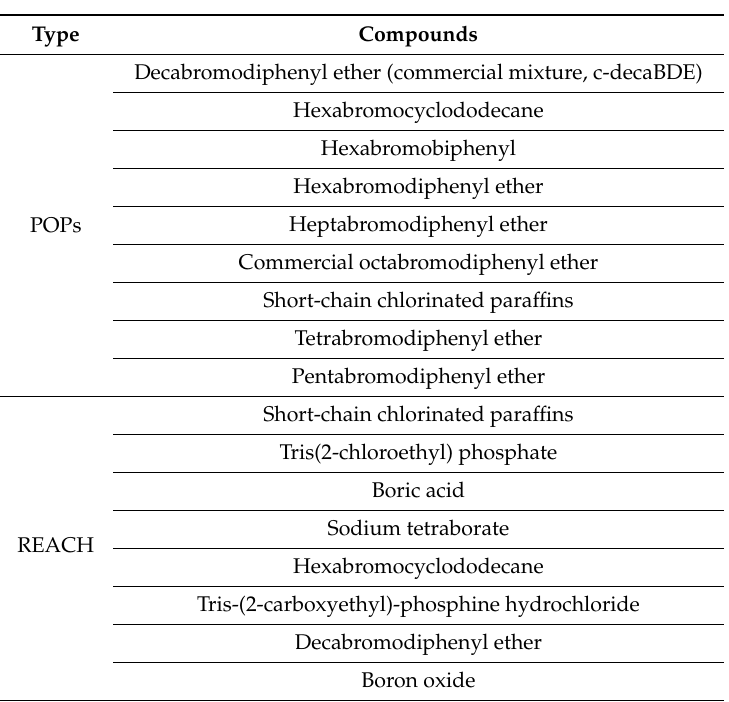
Table 1. Restrictive regulation for flame